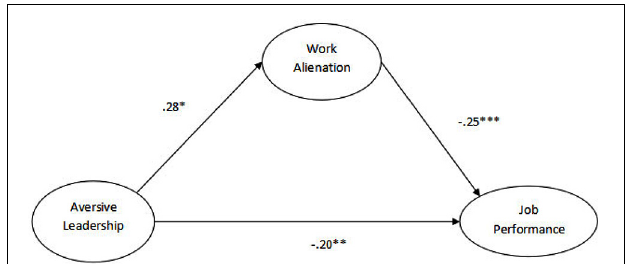
FIGURE 2 | SEM path diagram.